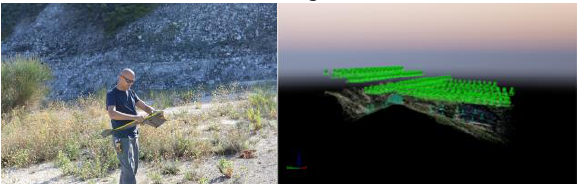
Figure 7. The eBee during the take-off (left) and the acquisition scheme of the images (right)